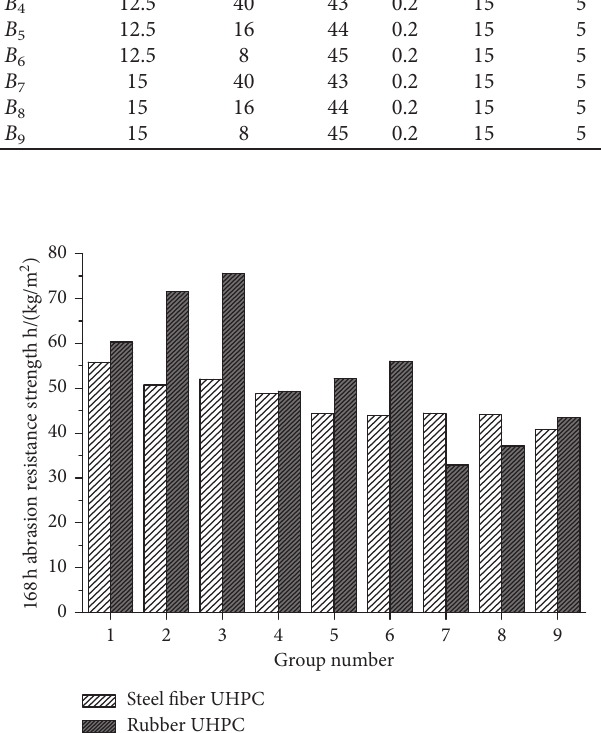
Figure 4: 168h abrasion resistance strength of rubber UHPC and steel fiber